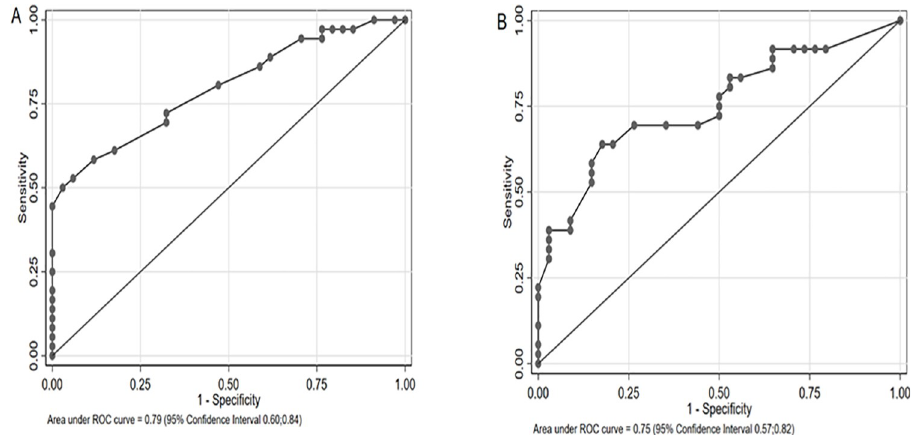
Fig 1. Receiver Operating Curve for (A) mitral valve leaflets thickness (mm) and (B) mitral regurgitation jet area (cm 2 ) at baseline examination and development of RHD at follow-up.